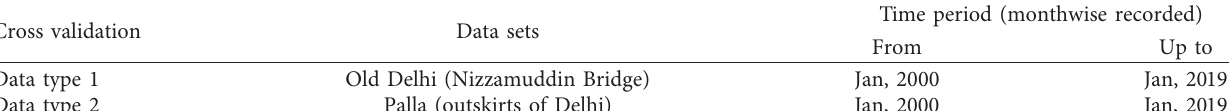
Table 1: Data sets for simulation of five hybrid models.